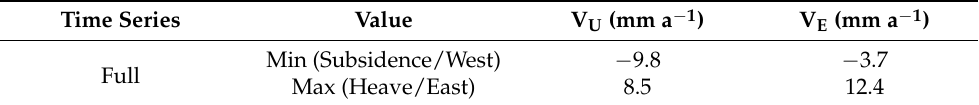
Table 5. Summary of min and max vertical (V U ) and horizontal (V E ) in Ventnor for full time series. Time